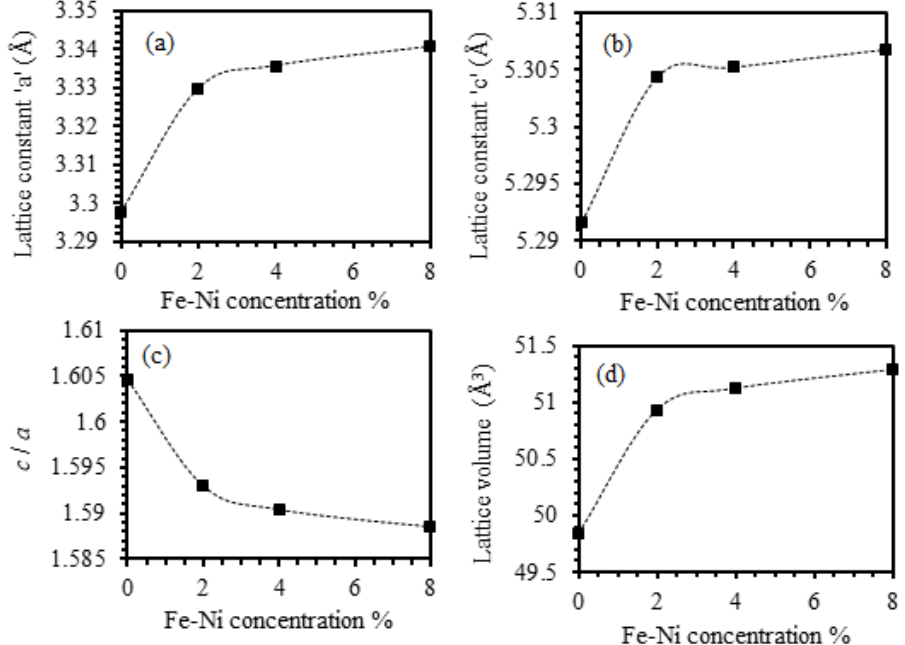
Figure 2. Lattice constants ( a and c ), the ratio of ( c / a ) and the lattice volume ( V ) determined from X-ray di ff raction pattern of the undoped ZnO and the Fe-Ni co-doped ZnO thin films as a function of (Fe-Ni) concentration. ( a ) In-plane lattice constant a as a function of (Fe-Ni) % concentration. ( b ) Out-of-plane lattice constant c as a function of (Fe-Ni) % concentration. ( c ) Axial ratio ( c / a ) as a function of (Fe-Ni) % concentration. ( d ) Lattice volume (V) as a function of (Fe-Ni) % concentration.